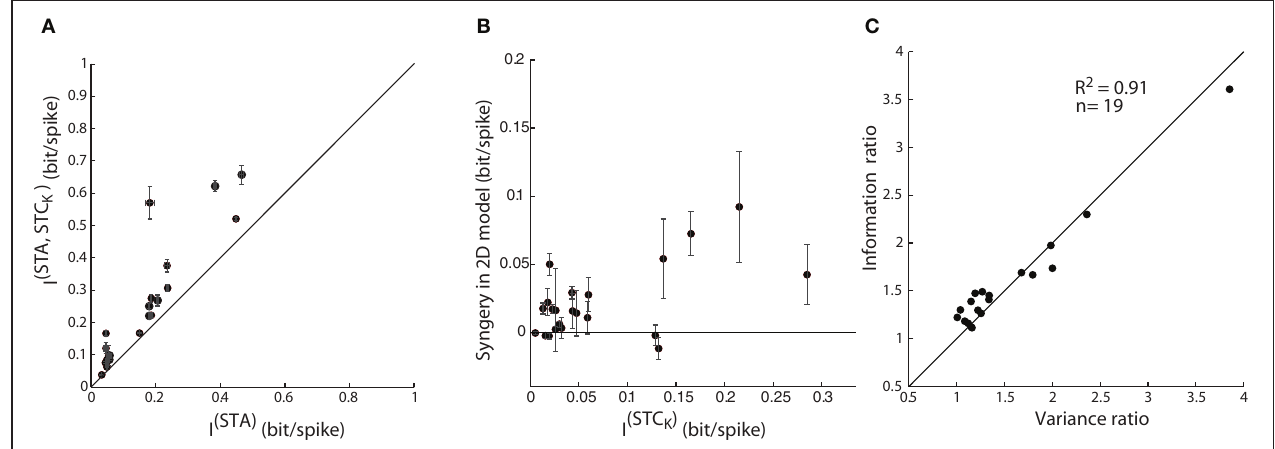
FIGURE 8 | Assessing model performance by using information theory. (A) Comparison of mutual information estimated from one vs. jointly by two subunits; as in Figure 7A . The error bars depict the standard deviation of the information value (circles) computed for different bin sizes used. (B) A plot of synergy (the amount of additional information encoded by the pair of subunits